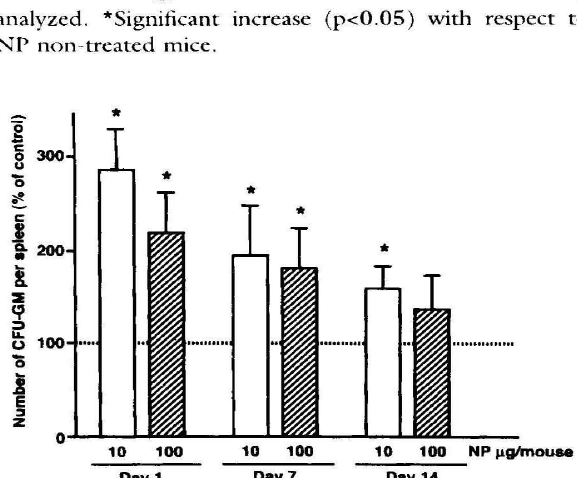
fIgure 1. Increase of peripheral leukocytes by NP treat ment. Peripheral blood was obtained from the animals :re.lted with or without NP via the retro-orbital plexus. or-he results were expressed as a percentage of control. =- .l.:h bar represents the mean ± SD obtained from five :11I.:e individually analyzed. *Significant increase (p<O.05) -'-!th respect to NP non-treated mice.